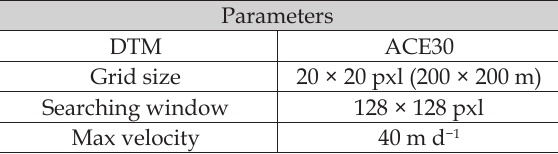
Table 2. Parameters for the offset-tracking